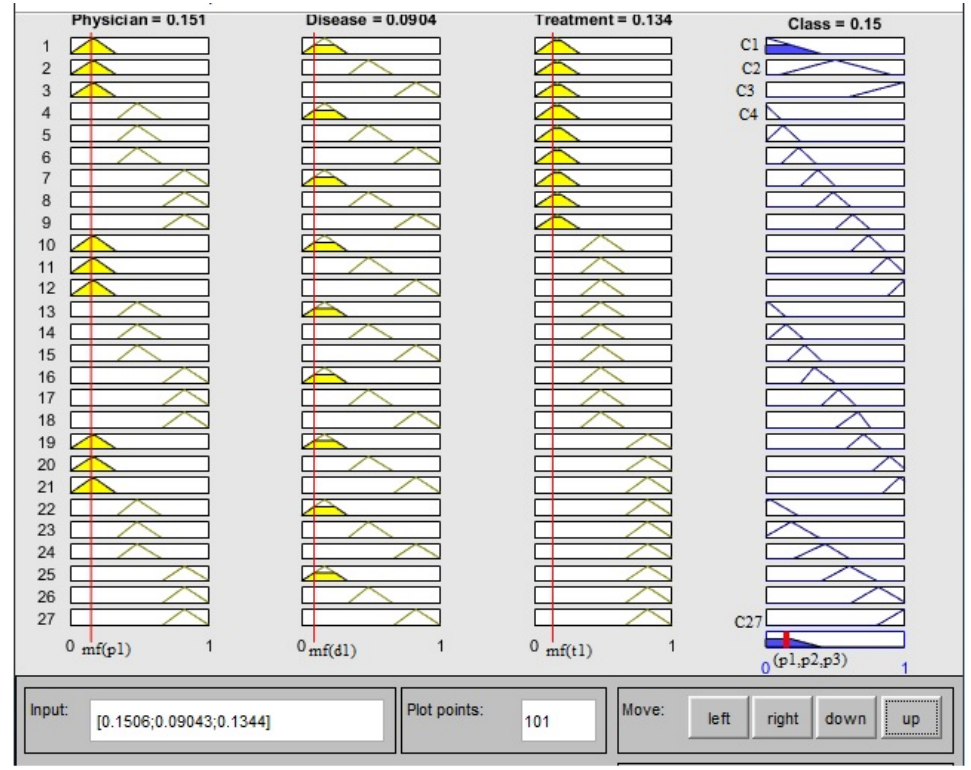
Figure 2. Matlab simulation of fuzzy logic, rules evaluation for Physician, Disease and